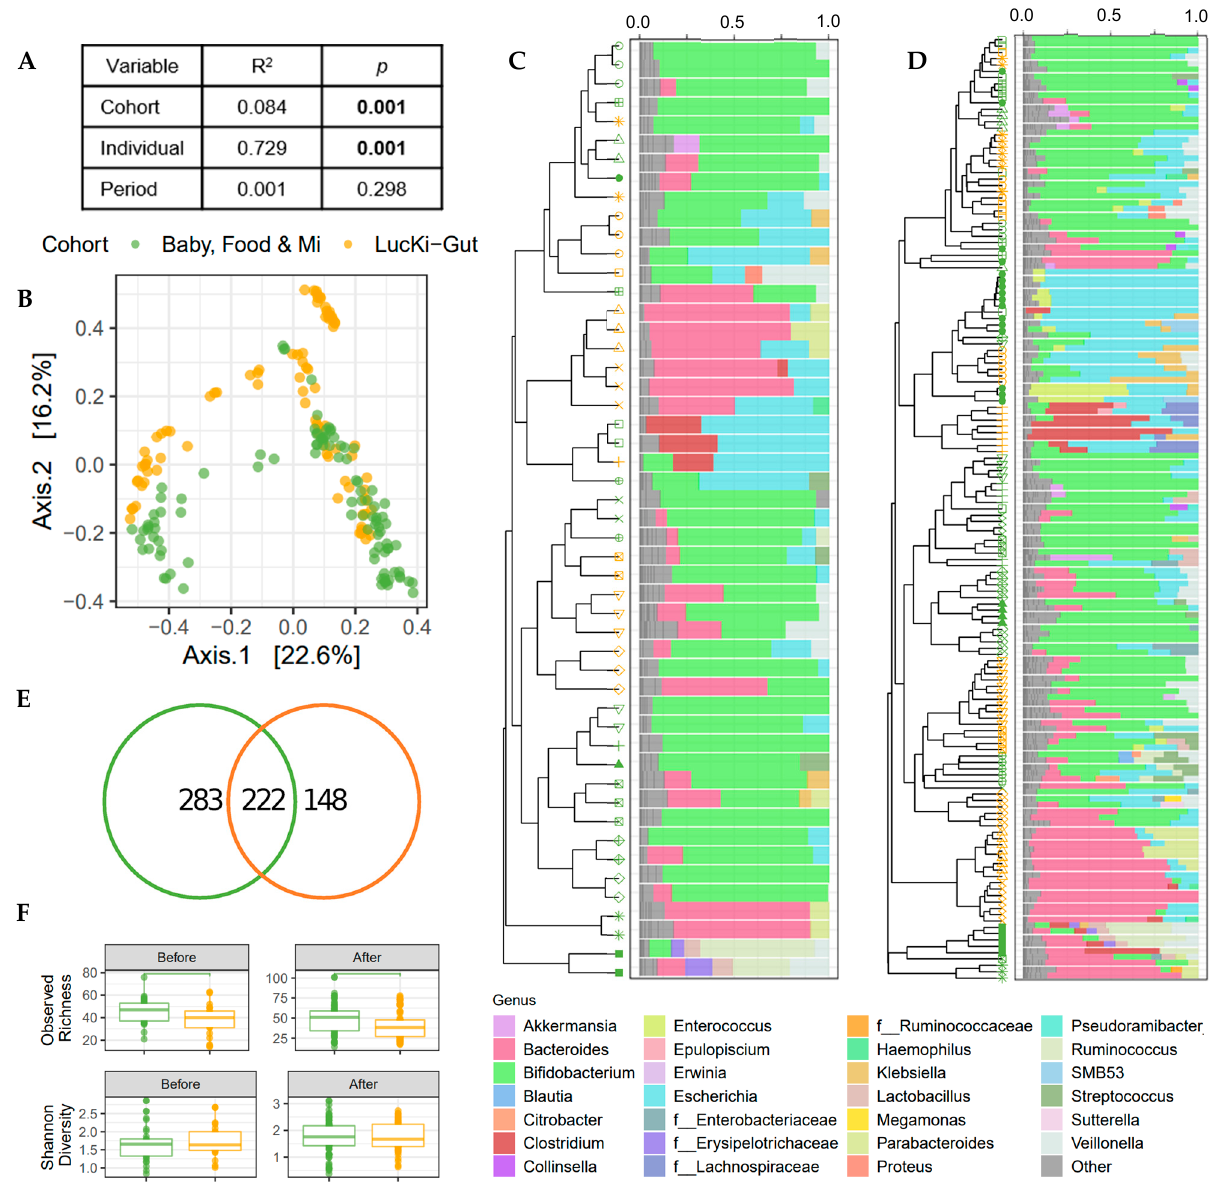
Figure 2. Bacterial communities differ by cohort; however, greater variability is seen between individuals. ( A ) Explained variance (R 2 ) and statistical significance of cohort (Baby, Food & Mi/LucKi-Gut sub-studies), individual and period (before/after solid food introduction) on the microbial community structure (Bray–Curtis dissimilarity) as determined by multivariable PERMANOVA on merged V3 data. ( B ) PCoA of microbial communities. ( C , D ) Dendrograms of UPGMA clustering of individuals by Bray–Curtis dissimilarity and relative genus abundance bar charts for each sample before the introduction of solids ( C ) and after the introduction of solids ( D ). Color of symbols indicate sub-study and shape of symbols indicate individual. Bacterial genera in “Other” include genera with a relative abundance < 5%. ( E ) Venn diagrams of the number of ASVs shared between the sub-studies. ( F ) Boxplots depicting the observed richness and Shannon diversity before and after the introduction of solid foods. For all panels green = Baby, Food & Mi, orange = LucKi-Gut.